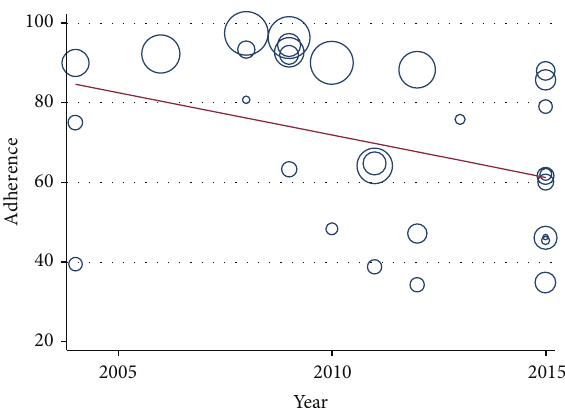
Figure 3: Metaregression of ACT adherence estimate by year of study publication.